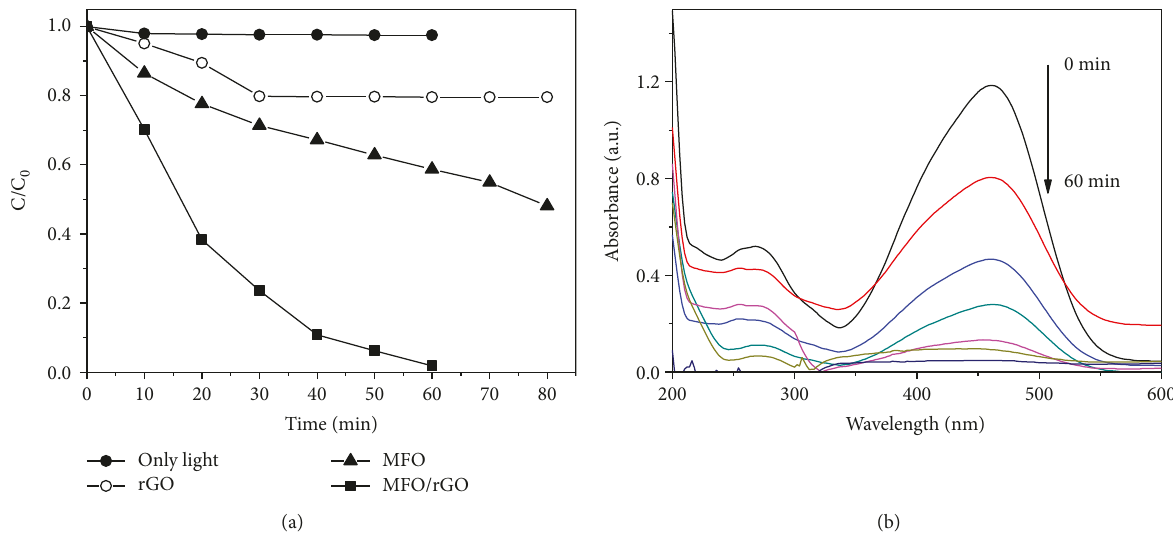
Figure 3: (a) Photocatalytic degradation pro fi le of MO under visible-light irradiation with and without catalyst versus exposure time, (b) absorption spectra of the MO (20 mgl − 1 ) solution at di ff erent photocatalytic time under MFO/rGO